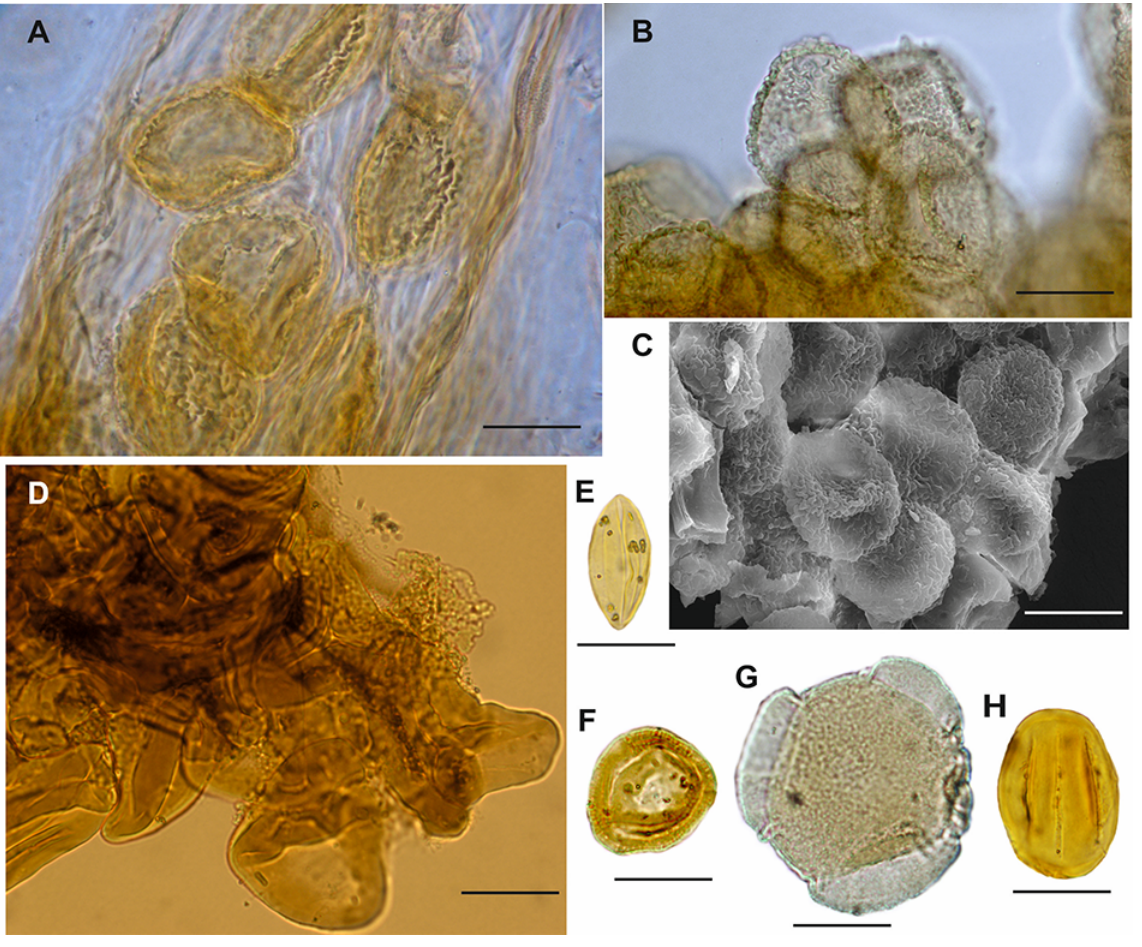
Figure 2 In situ miospores of Triassic and Jurassic and characteristic miospores of Jurassic: ( A ) Enzonalasporites sp. in situ pollen grains inside micropylar canal of the ovule of the voltzialean conifers Patokaea silesiaca , LM (phase contrast), KRA-PALEO 104/36, Patoka, Upper Triassic; ( B ) Enzonalasporites sp. in situ pollen grains from the pollen sac of the voltzialean conifers Patokaea silesiaca , LM, KRA-PALEO 104/100, slide KRA-PALEO 104/100/2, Patoka, Upper Triassic; ( C ) Enzonalasporites sp. in situ pollen grains from the marginal part of the pollen sac of the voltzialean conifers Patokaea silesiaca , SEM, KRA-PALEO 104/100, Patoka, Upper Triassic – stored at the Institute of Botany, Jagiellonian University, under the palaeobotanical collection number KRA-PALEO 104; ( D ) group of in situ spores from the matoniaceous fern Matonia braunii , LM, Niekłań, Lower Jurassic; ( E ) Monosulcites minimus pollen grains of ginkgos, LM, KRAM P PM Grojec II 53/6/07, Grojec, Middle Jurassic; ( F ) Classopollis torosus pollen grain of conifer (Cheirolepidiaceae), LM, KRAM P PM 68/6/1/6, Odrowąż (Sołtyków), Lower Jurassic; ( G ) Callialasporites trilobatus – araucariaceous pollen grain, LM, KRAM P PM 56/57II/1, Wólka Bałtowska, Upper Jurassic; ( H ) Eucommiidites troedsonii pollen grain from gymnosperms (Erdtmanithecaleans), LM, KRAM P PM Grojec II 53/6/07, Grojec, Middle Jurassic – stored in paleobotanical collection (Palaeozoic and Mesozoic) of the National Biodiversity Collection – Herbarium KRAM at W. Szafer Institute of Botany, Polish Academy of Sciences, Kraków (KRAM P PM). Scale bar: 20 µm. Photos by J. Ziaja ( A,B,D,H ) and K. Bóka ( C